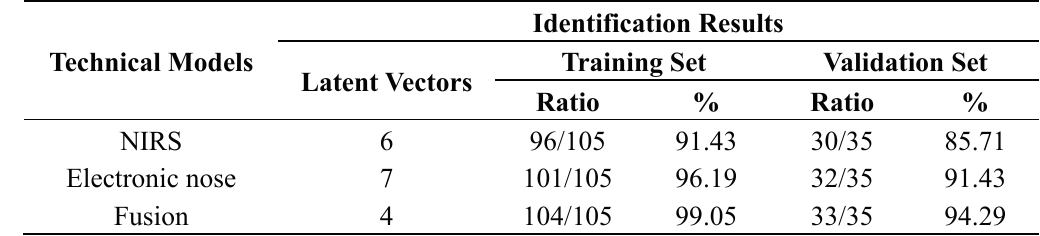
Table 2. Results and comparison of the best BP_AdaBoost models based on different